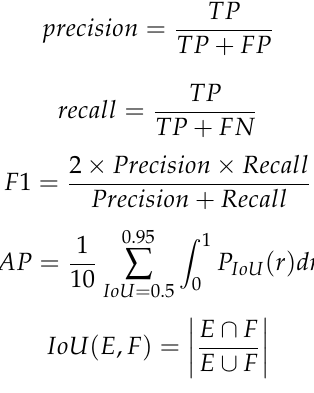
Figure 3. A flowchart of the proposed approach for training dual models.